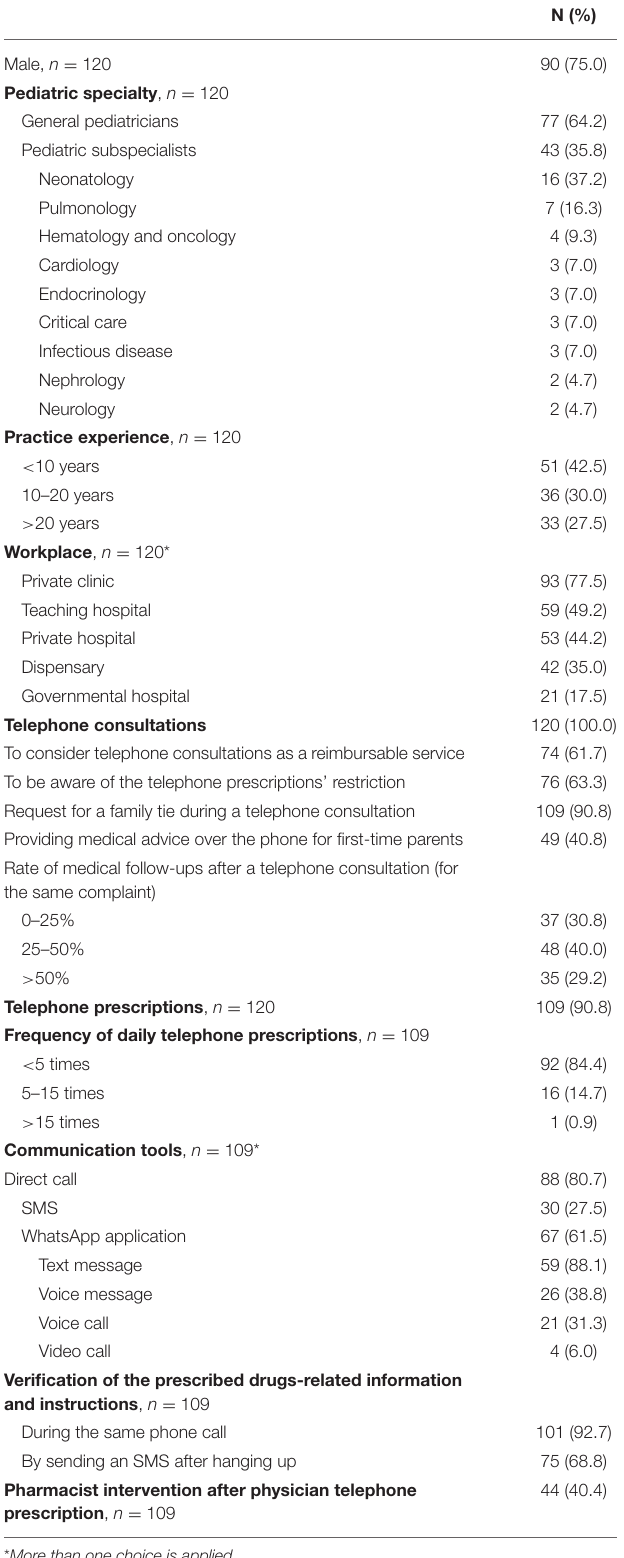
TABLE 1 | Participants’ clinical characteristics, phone consultations, and prescription-related